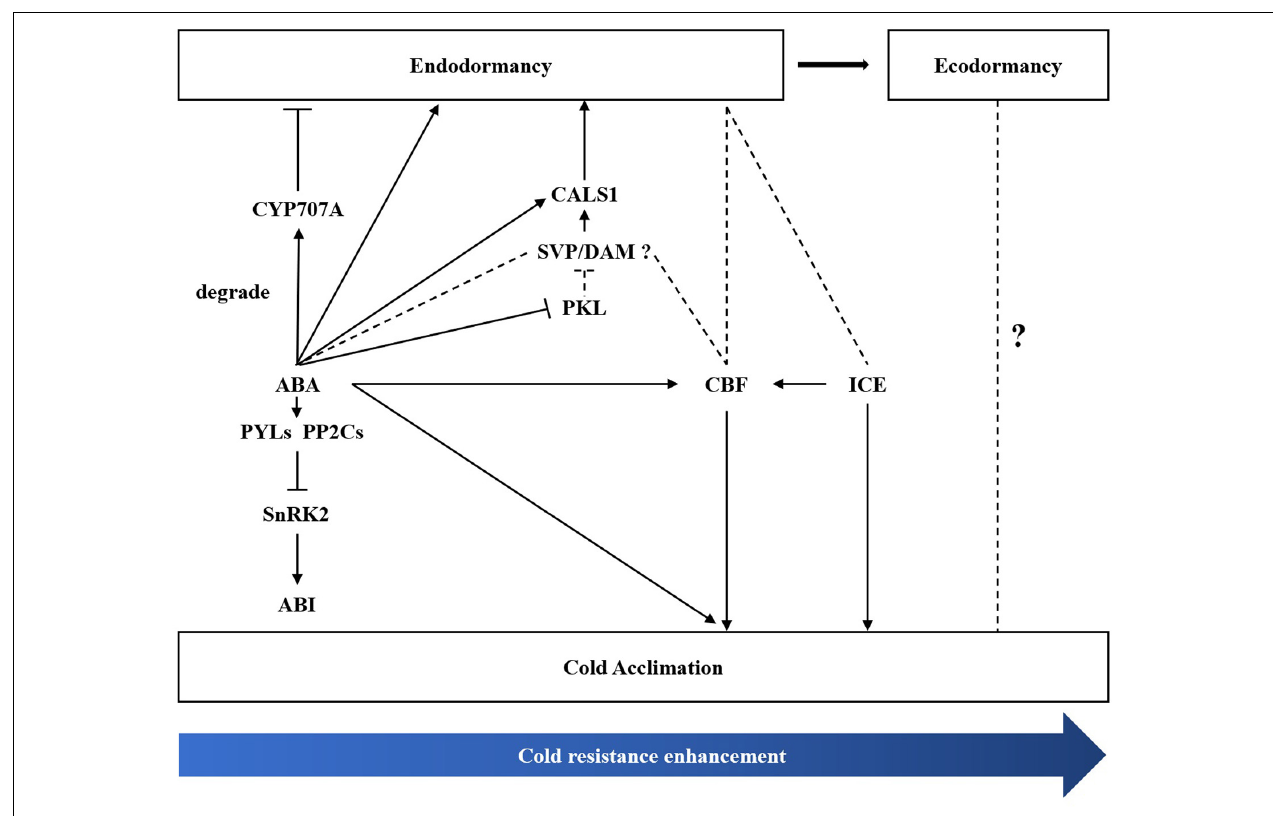
FIGURE 10 | A hypothesis of molecular regulation model between bud dormancy and cold acclimation during winter in Magnolia wufengensis .